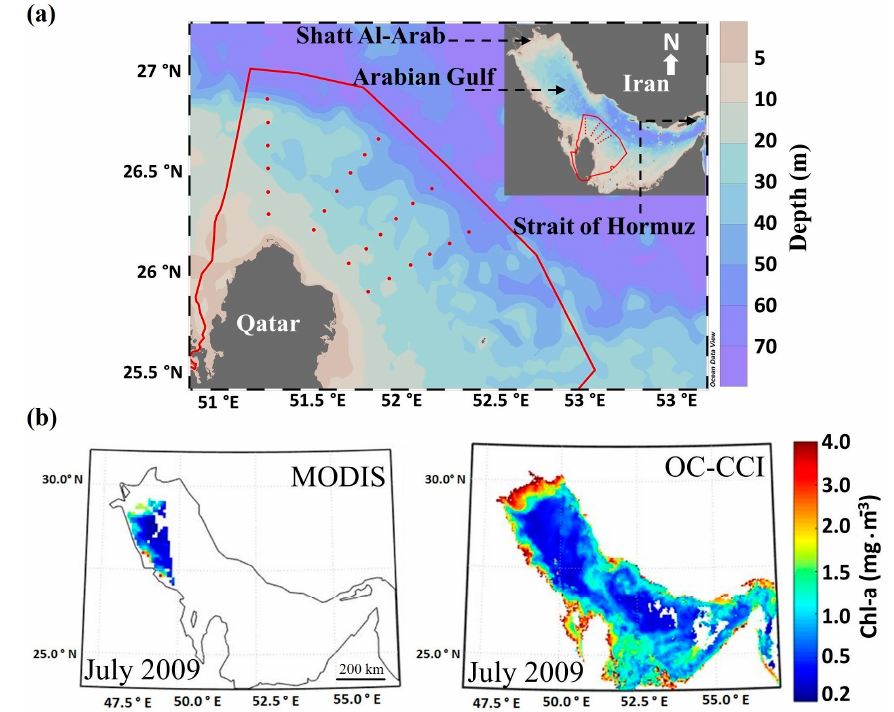
Figure 1. Bathymetry of the Arabian Gulf and ocean colour data availability ( a ) Sampling stations along Qatar’s Exclusive Economic Zone (EEZ). The red circles denote the total of 24 stations spread at the northern and northeastern parts of the EEZ. The inset panel shows the Arabian Gulf, Shatt Al-Arab region and the study area outlined with a red polygon representing Qatar’s EEZ. ( b ) Ocean colour Chlorophyll- a measurements (Chl -a ) maps for July 2009: the left panel was produced using only MODIS Level 3 data, illustrating a poor data coverage over the Arabian Gulf region. In contrast, the right panel was produced using OC-CCI data showing an improved coverage of the Arabian Gulf by utilizing merged sensors’ datasets.